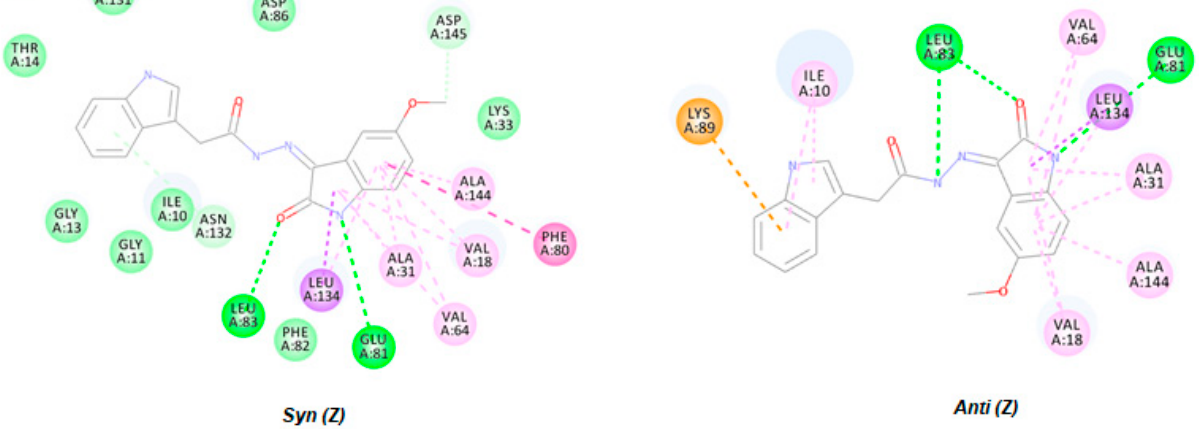
Figure 4. Two-dimensional representation of docking poses of HI 5 geometric isomers ( E and Z ).